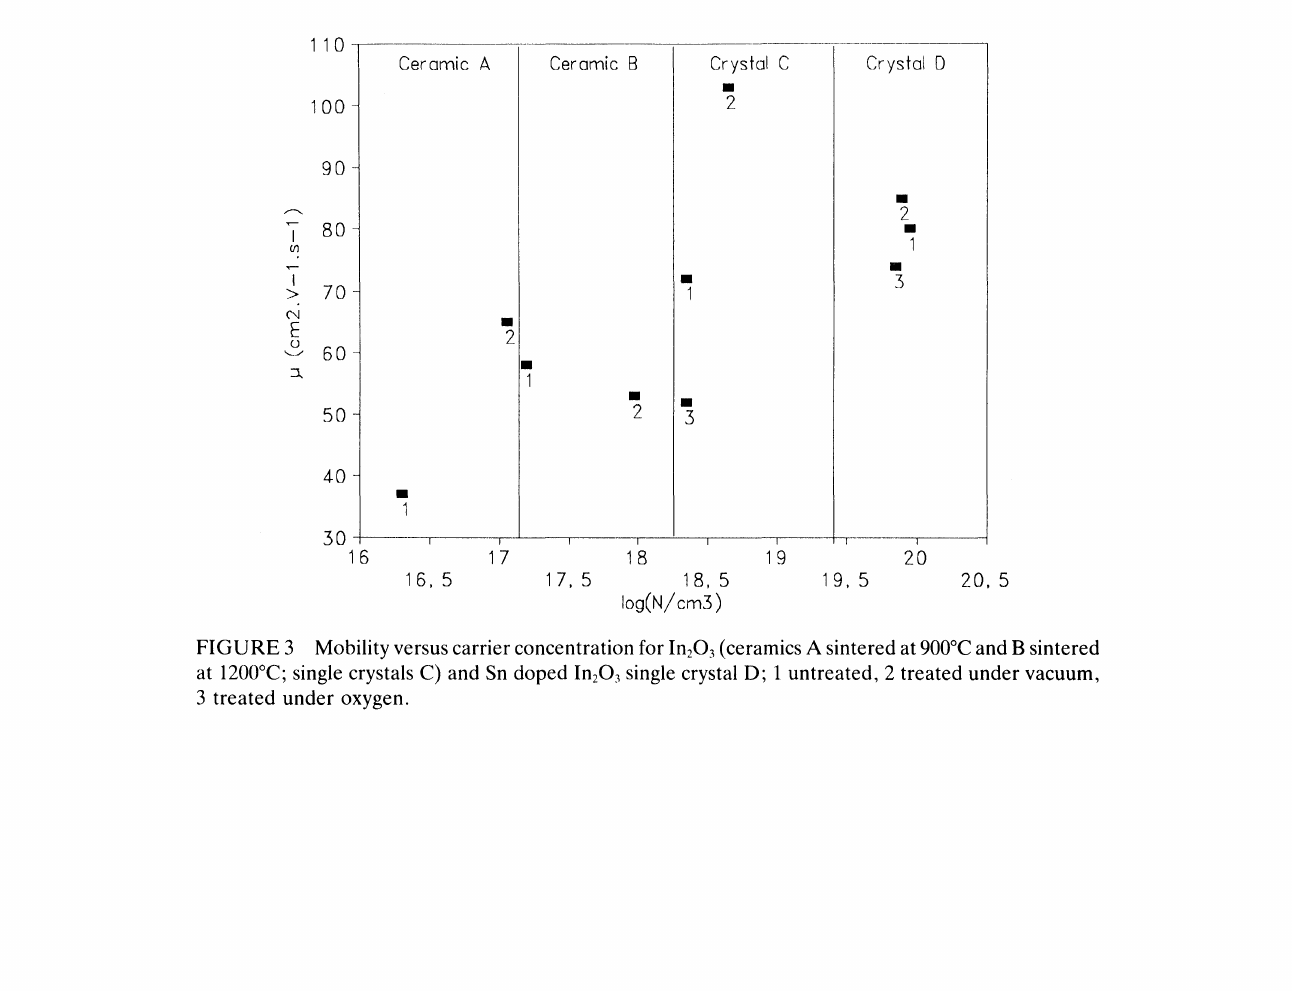
FIGURE 2 Mobility versus carrier concentration for In203 ceramics sintered at various temperatures (oc).